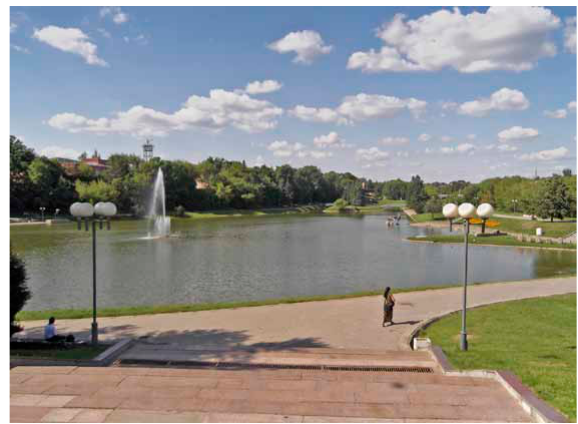
fig. 17. The specific feature of the spatial structure of the town of Telšiai is its functional and visual connection with the space of the lake. E. ramanauskas